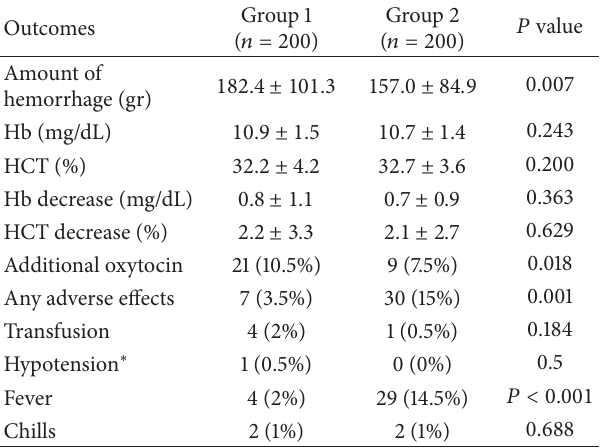
Table 1: Comparison of study outcomes in the two